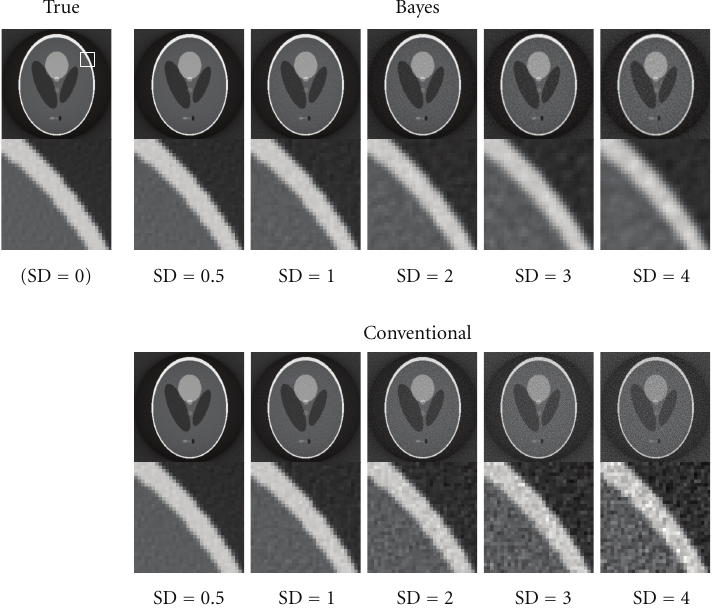
Figure 2: Comparison of the reconstructed tomography images derived using the Bayesian method and conventional FBP. The top row shows the Bayesian FBP methods, and the bottom one shows the conventional one. Each column corresponds to the strength of the observation Gaussian noise standard deviations. We show the magnification of a part of the reconstructed images around the edge of the phantom, whose location is indicated by white rectangle in the true